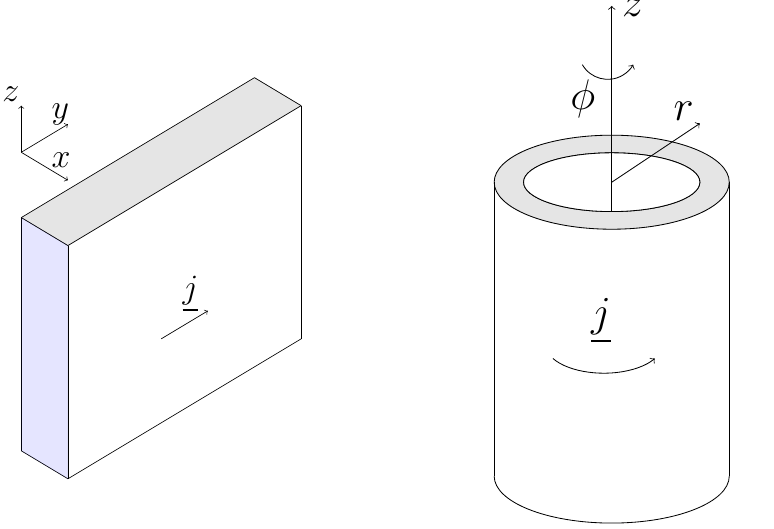
Figure 1 . A sketch of the orientation of the domain wall and the vorton, each with current j